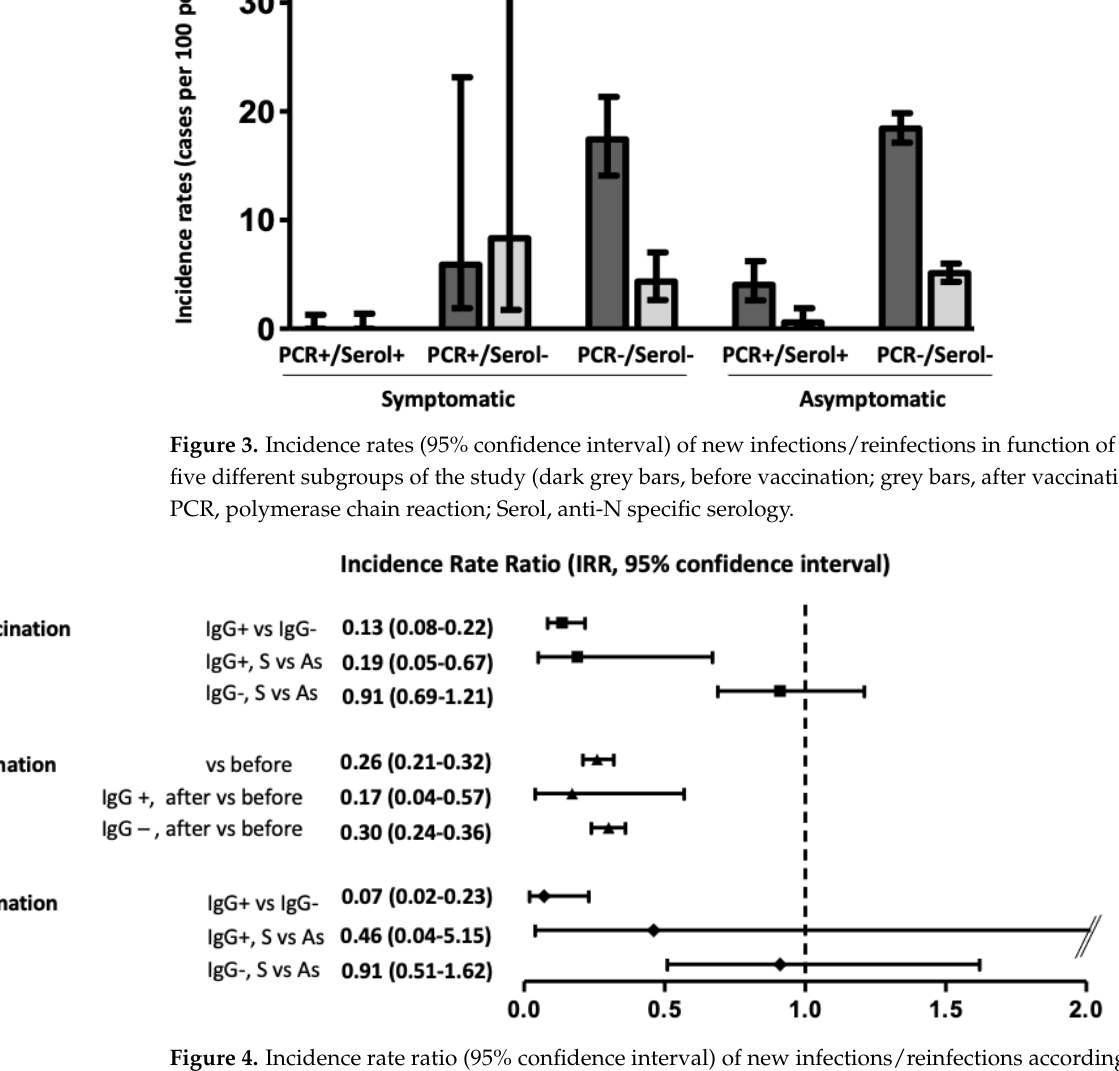
Figure 4. Incidence rate ratio (95% confidence interval) of new infections/reinfections according to period before or after vaccination, presence or no of specific antibodies, and classified as symptomatic or asymptomatic at the first surge of the disease. IgG, specific anti-N serology; S, symptomatic; As,